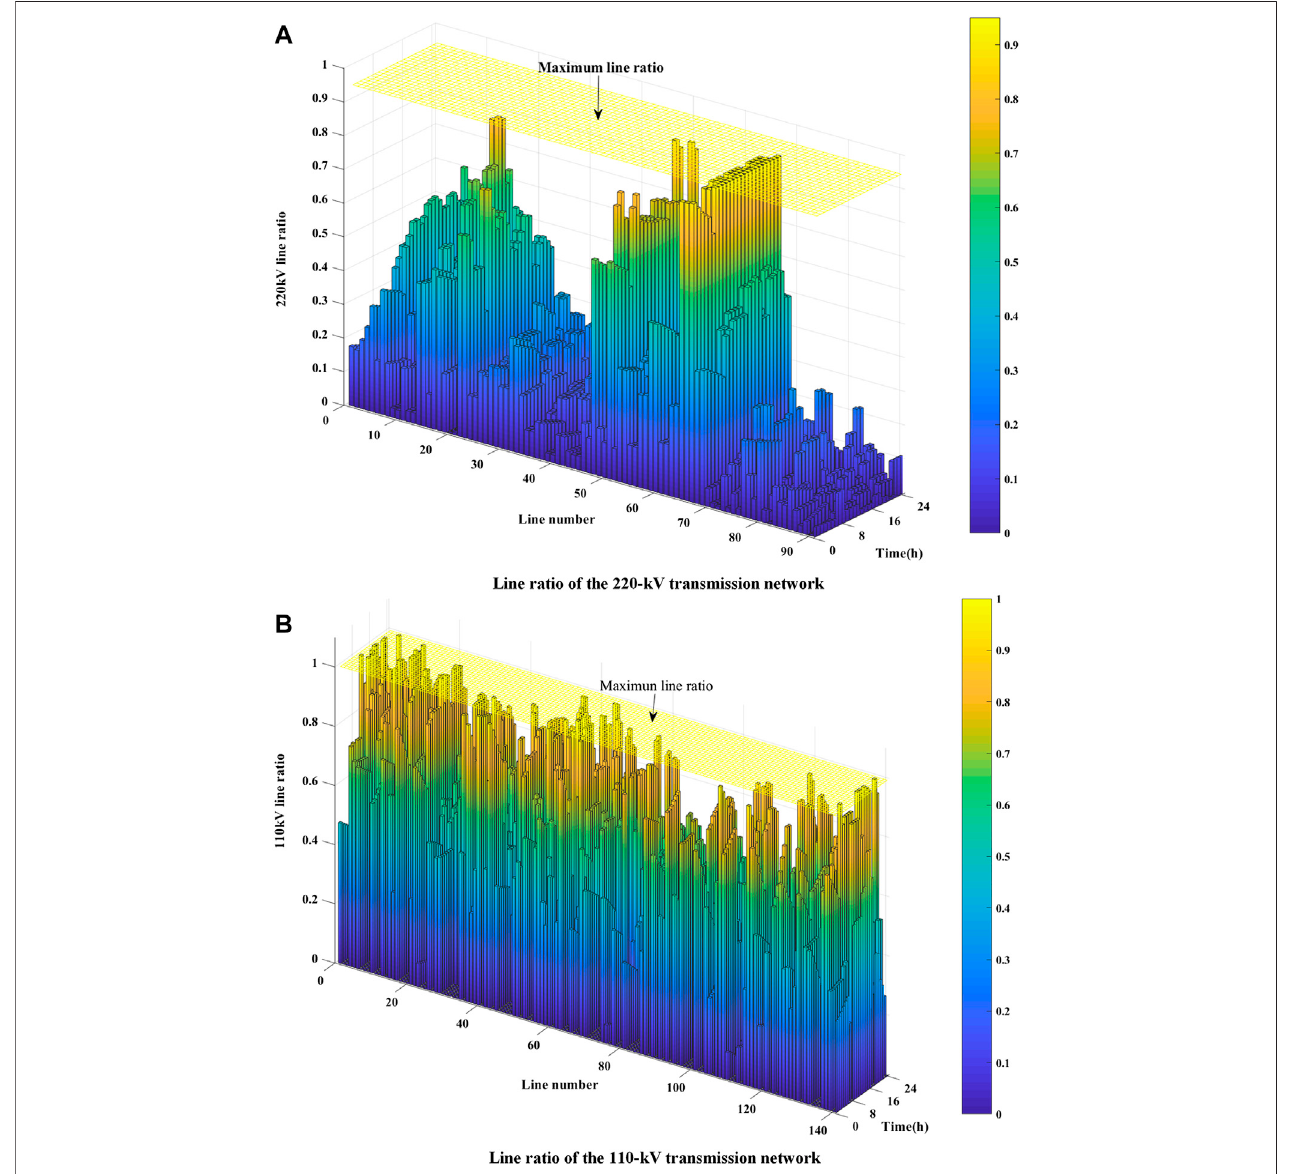
FIGURE 12 | System operation condition. (A) line ratio of the 220-kV transmission network. (B) line ratio of the 110-kV transmission network.